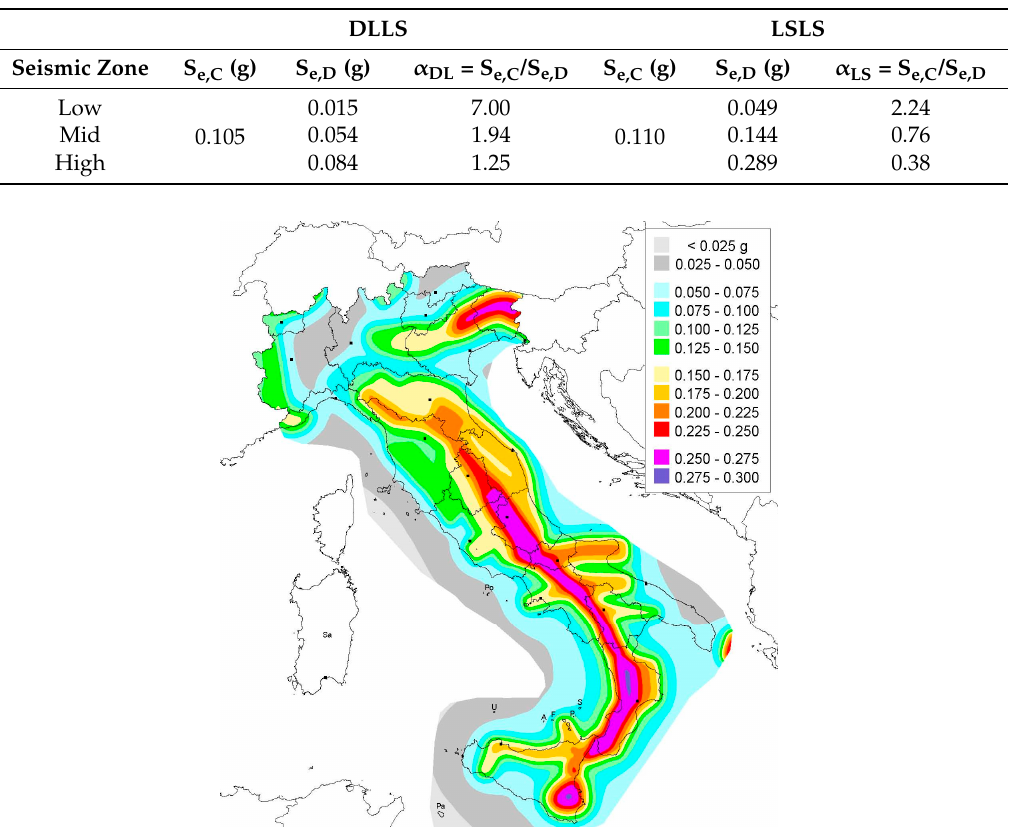
Figure 7. Italian seismic hazard map in terms of PGA according to [74].